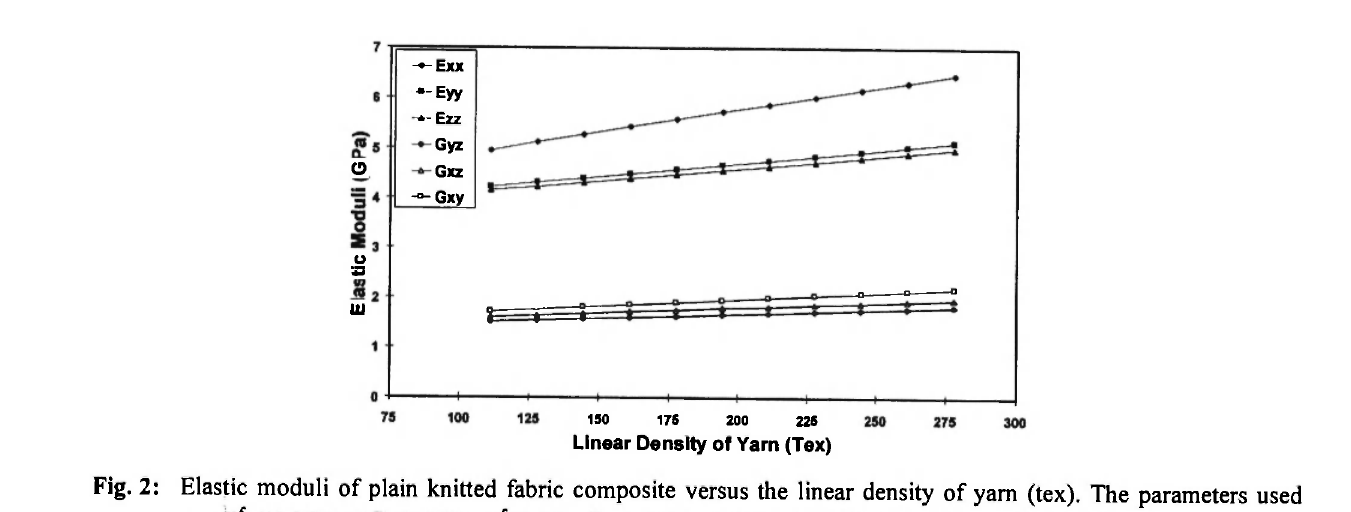
Fig. 2: Elastic moduli of plain knitted fabric composite versus the linear density of yarn (tex). The parameters used are: E f =74.0GPa, E m =3.6GPa, v f =0.23, v m = 0.35, C=2.5 loop/cm, W=2 loop/cm, and t=0.06cm.